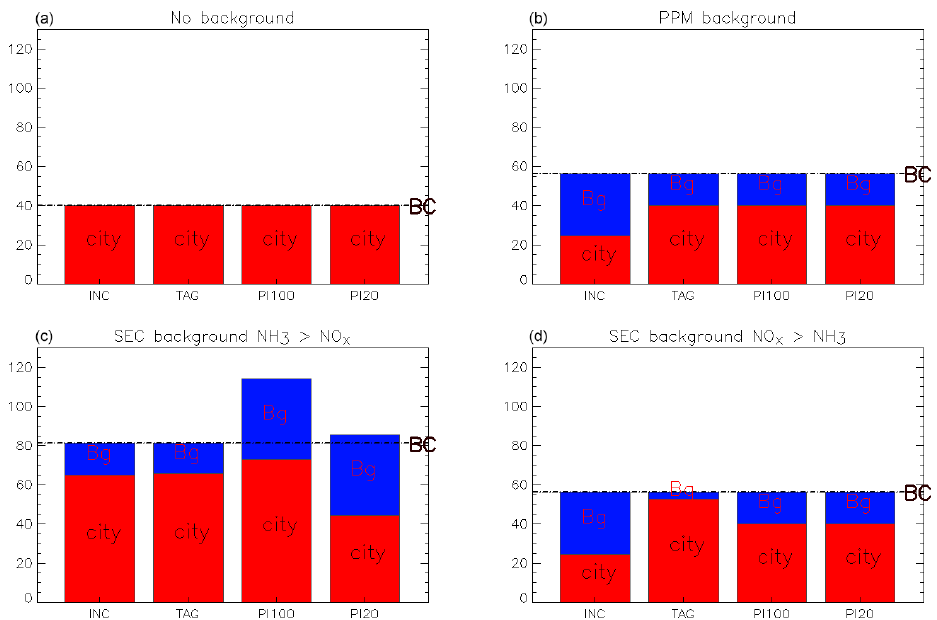
Figure A2. Comparison of the city (red) and background (blue) components for four approaches applied to the theoretical examples described in Fig. A1. Results are expressed for different types of background: (a) no background, (b) background limited to PPM, (c) background limited to secondary but with NH 3 > NO x , and (d) background limited to secondary but with NH 3 < NO x